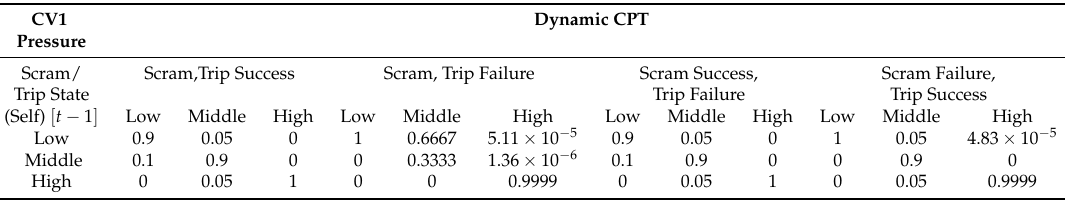
Table 2. Dynamic conditional probability table (CPT) for CV1 Pressure Measurements. Note the columns with the round estimates (expert-based opinions) interspersed with the more precise estimates based on the available data.